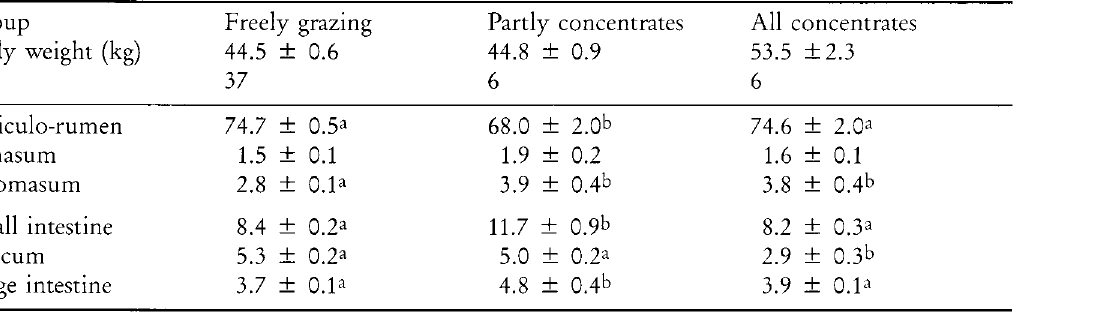
Table 2. Proportions of regions (%,x ± S.E.) of total gastro-intestinal weight in reindeer calves fed three different diets.